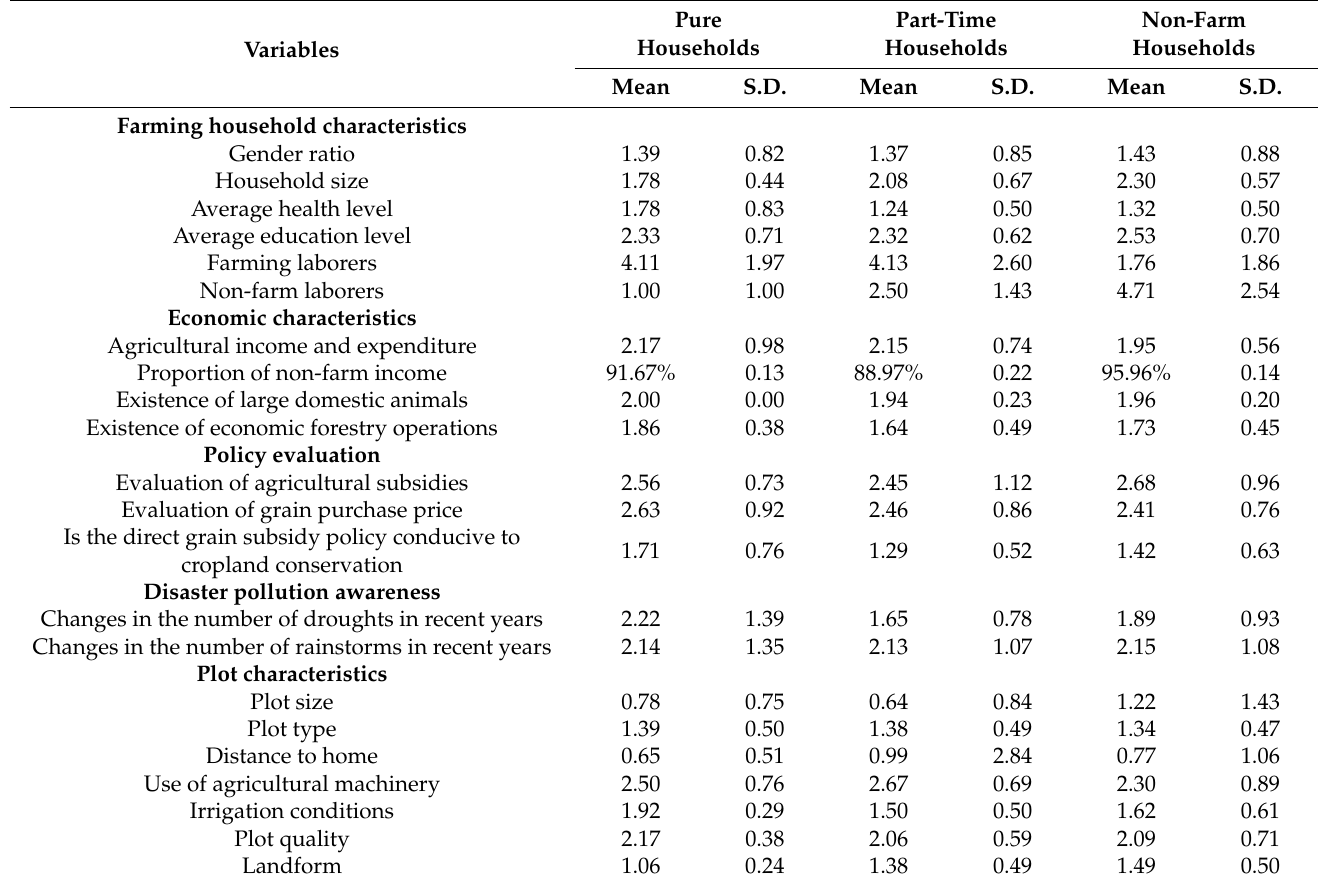
Table 2. Wenquan Township (mountainous topographic